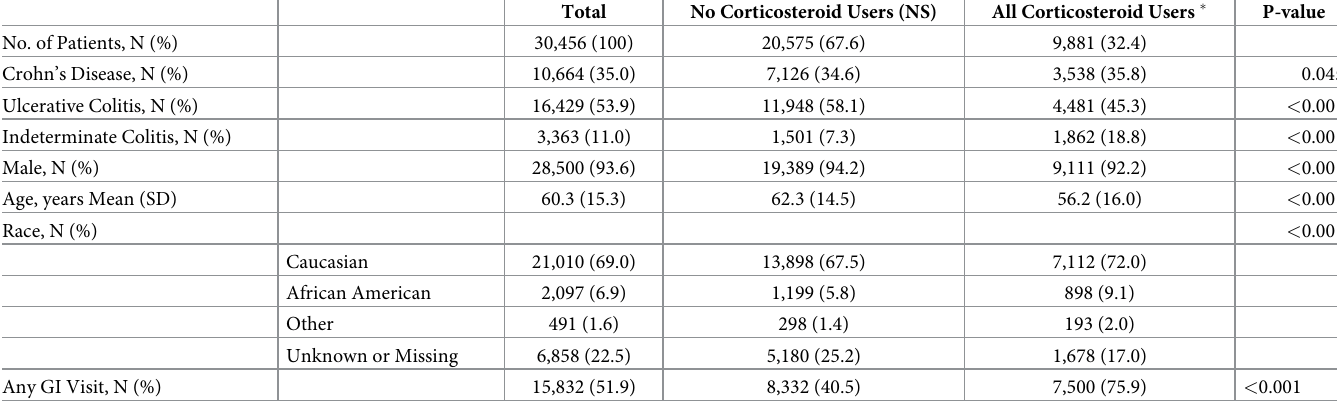
Table 1. Patient characteristics of no corticosteroid and all corticosteroid users among IBD